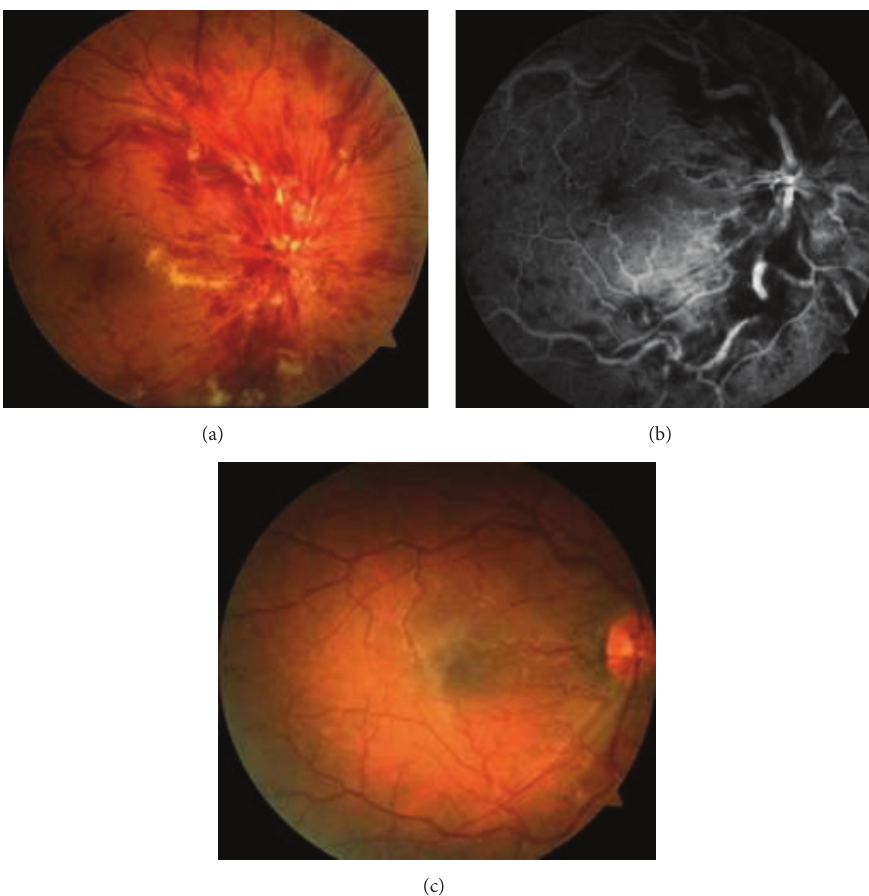
Figure 1: (a) Fundus photograph of the left eye shows central retinal vein occlusion with disk edema, dilated retinal veins, peripapillary cotton-wool spots, and hemorrhages. (b) Fluorescein angiogram (1 minute and 14 seconds after injection of the dye) photograph of the left eye shows central retinal vein occlusion with marked delay in arteriovenous transit time, masked by retinal hemorrhages, vessel wall staining, and a few small patches of retinal capillary obliteration. (c) Fundus photography of the left eye after 8 weeks shows that superficial cotton-wool spots and retinal hemorrhages were all